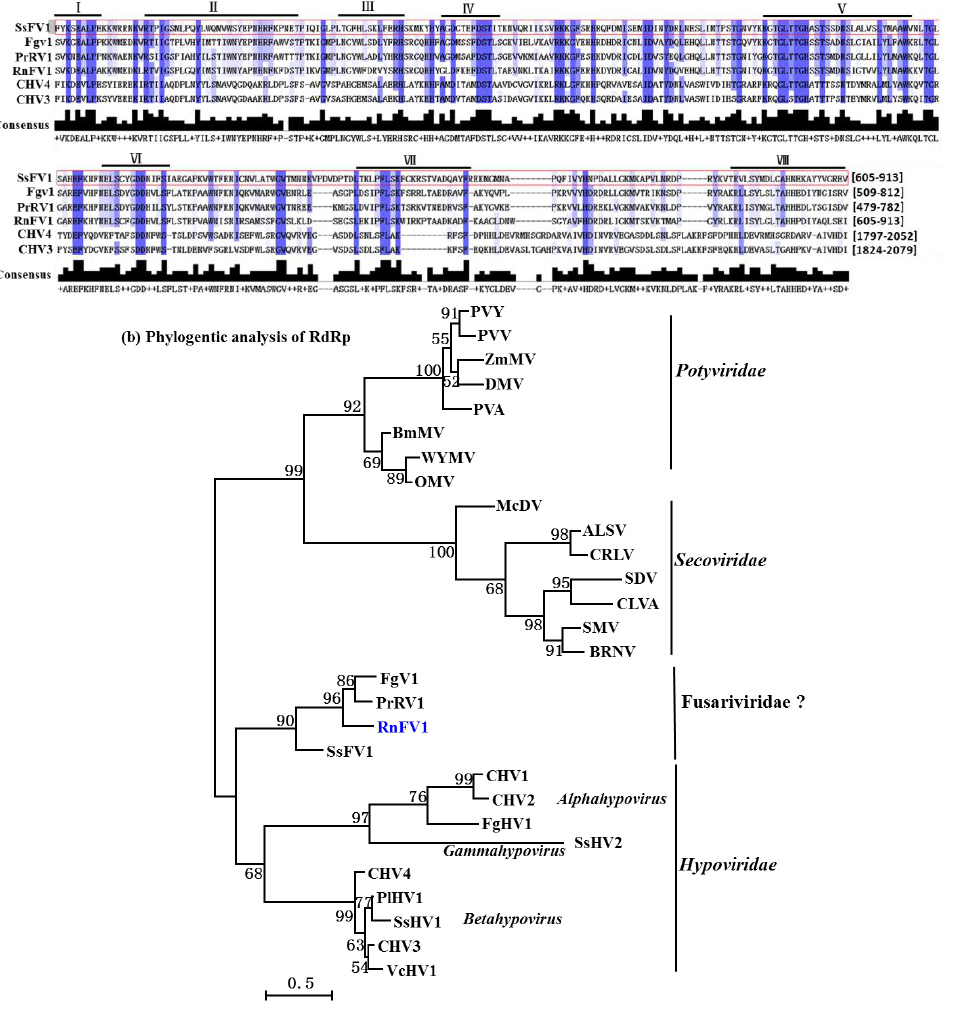
Figure 3. Cont Figure 3. Cont .